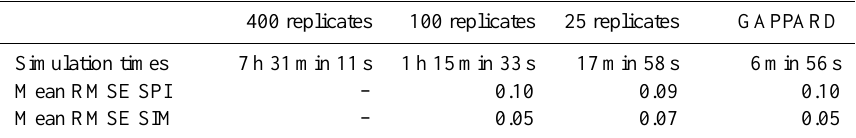
Table 4. Simulation times and mean RMSE. Sum of simulation times of all 8 simulated stands for 800yr of spinup and simulation from 1900–2100 with LPJ-GUESS using replicate patches and using the new GAPPARD method. RMSE for model spinup of 800yr (RMSE SPI) and for the simulation time 1900–2080 (RMSE SIM). The mean RMSE is calculated using all species that produced at least 0.5kgCm − 2 in one of both models at any point in time during the simulation. The reference to RMSE calculation is always LPJ-GUESS with 400 replicate patches. The 400-replicate run was done once, the others shown as means of 10 simulation runs that use the same random number of seeds for stochasticity (thereby producing the same output) to account for the different loads of the processor nodes. Simulations were run on one core of an AMD Opteron 2439 2.8GHz